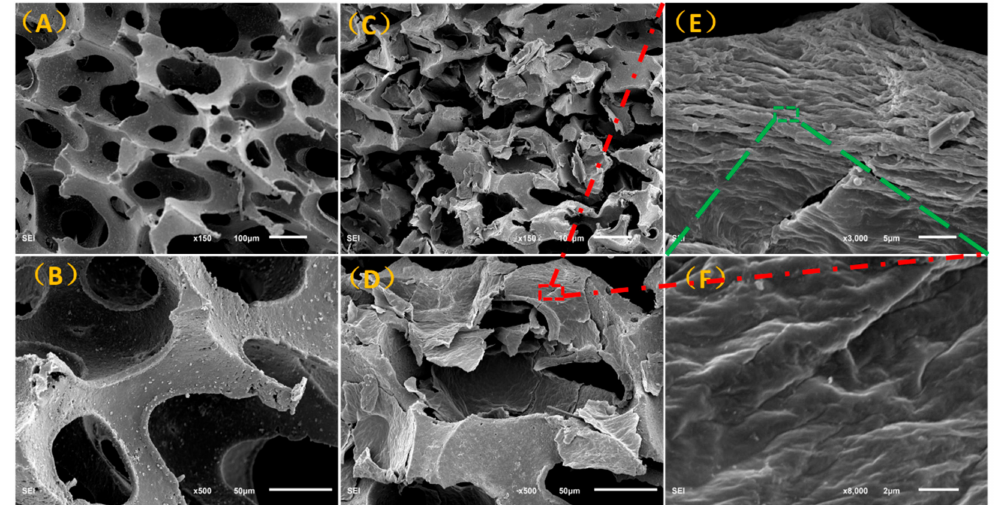
Figure 4. Scanning electron microscopy (SEM) images of pure polyurethane (PU) foam ( A , B ) and reduced graphene oxide / polyurethane (rGO / PU) foam ( C – F ) with varying